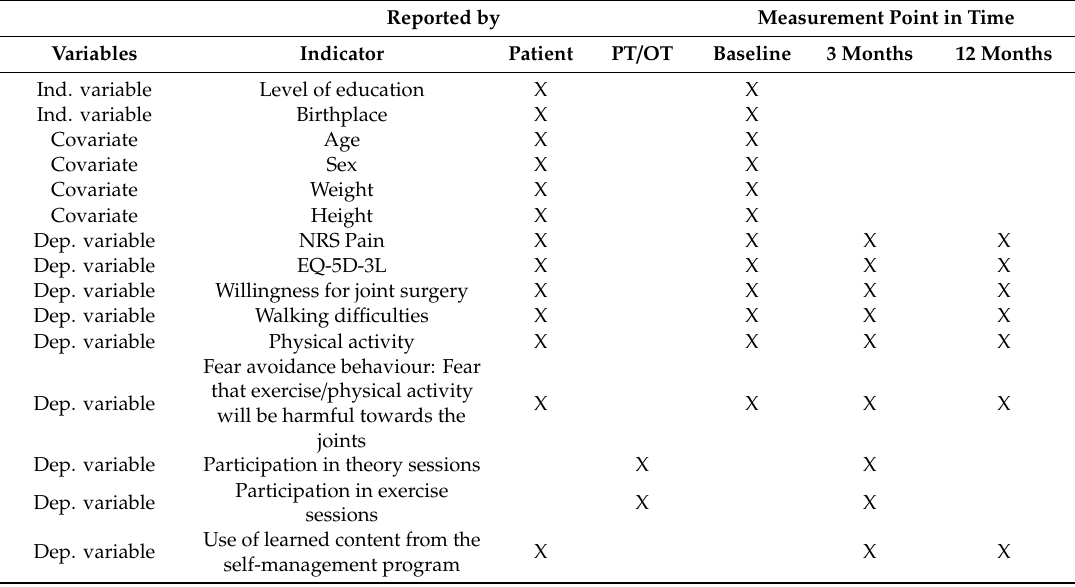
Table A1. Included variables for the study.